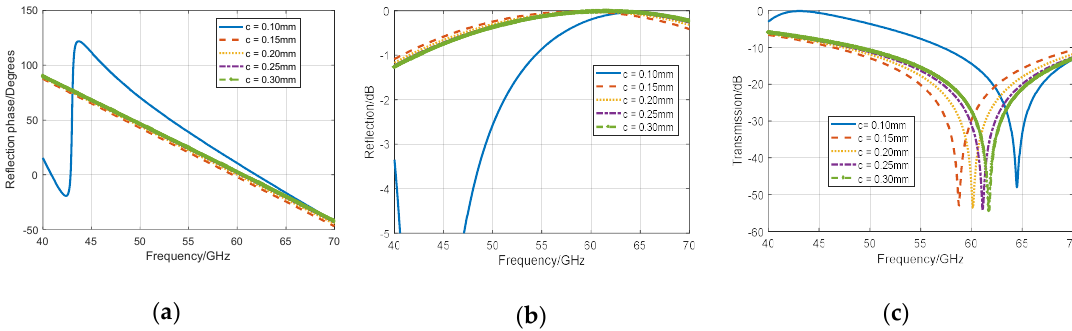
Figure 8. Reflection phase, reflection coefficient and transmission coefficient of the dual loop metasurface at the varied thickness of the square loop, ‘c’: ( a ) Reflection phase, ( b ) reflection coefficient and ( c ) transmission coefficient.